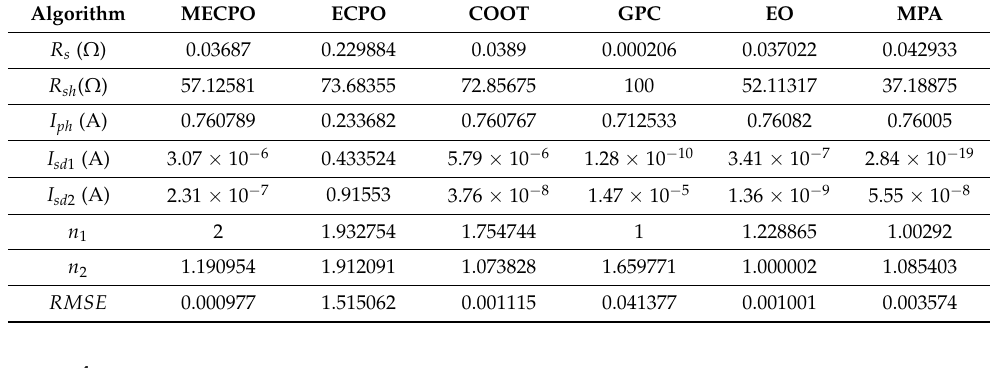
Table 9. Calculated parameter in case of the DDM obtained by the proposed algorithm and other recent techniques.